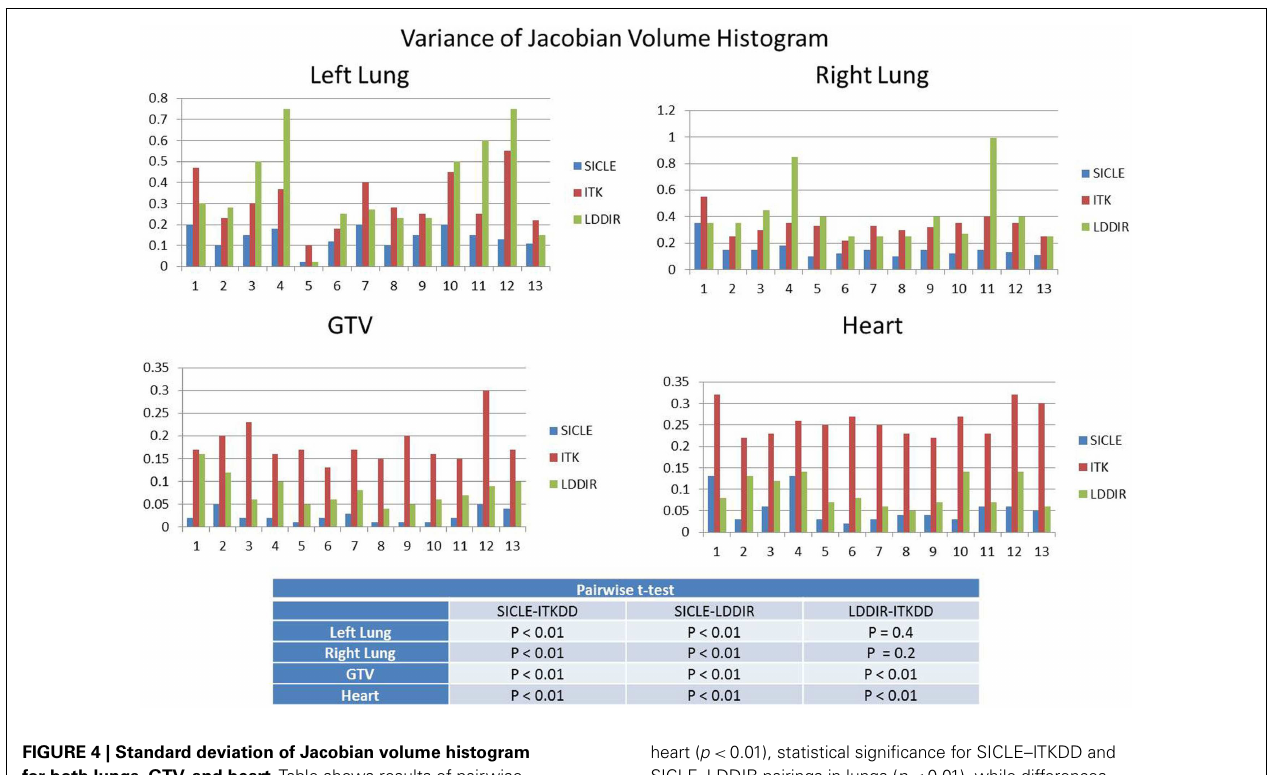
FIGURE 4 | Standard deviation of Jacobian volume histogram for both lungs, GTV, and heart .Table shows results of pairwise t -test analysis to assess if differences are statistically significant. Results indicate statistical significance for all pairings in GTV and